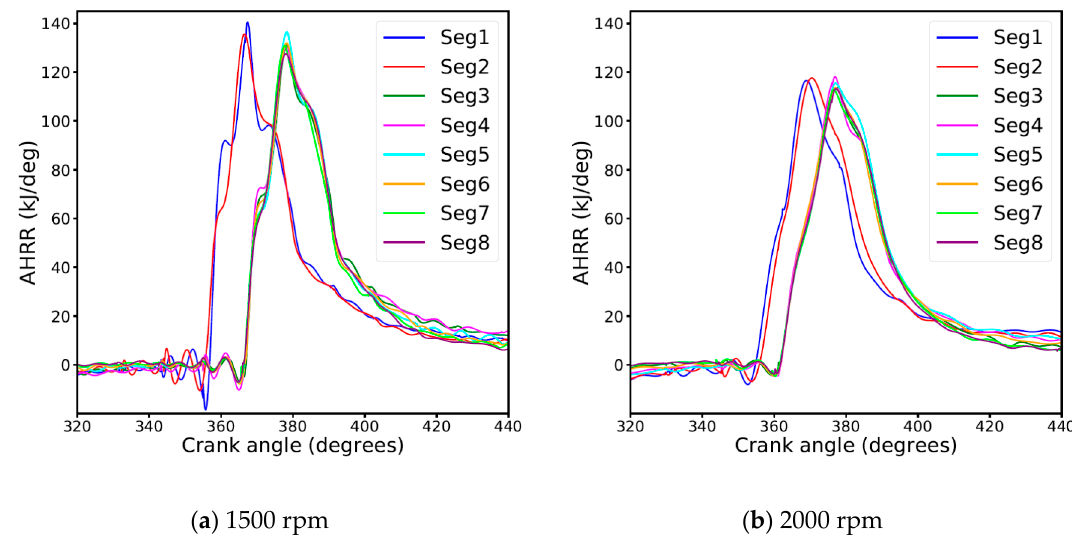
Figure 7. AHRR at 75% load in each segment in all stages at ( a ) 1500 rpm and ( b ) 2000 rpm. The blue line represents Segment 1, red line represents Segment 2, green line represents Segment 3, magenta line represents Segment 4, cyan line represents Segment 5, orange line represents Segment 6, lime line represents Segment 7 and purple line represents Segment 8.